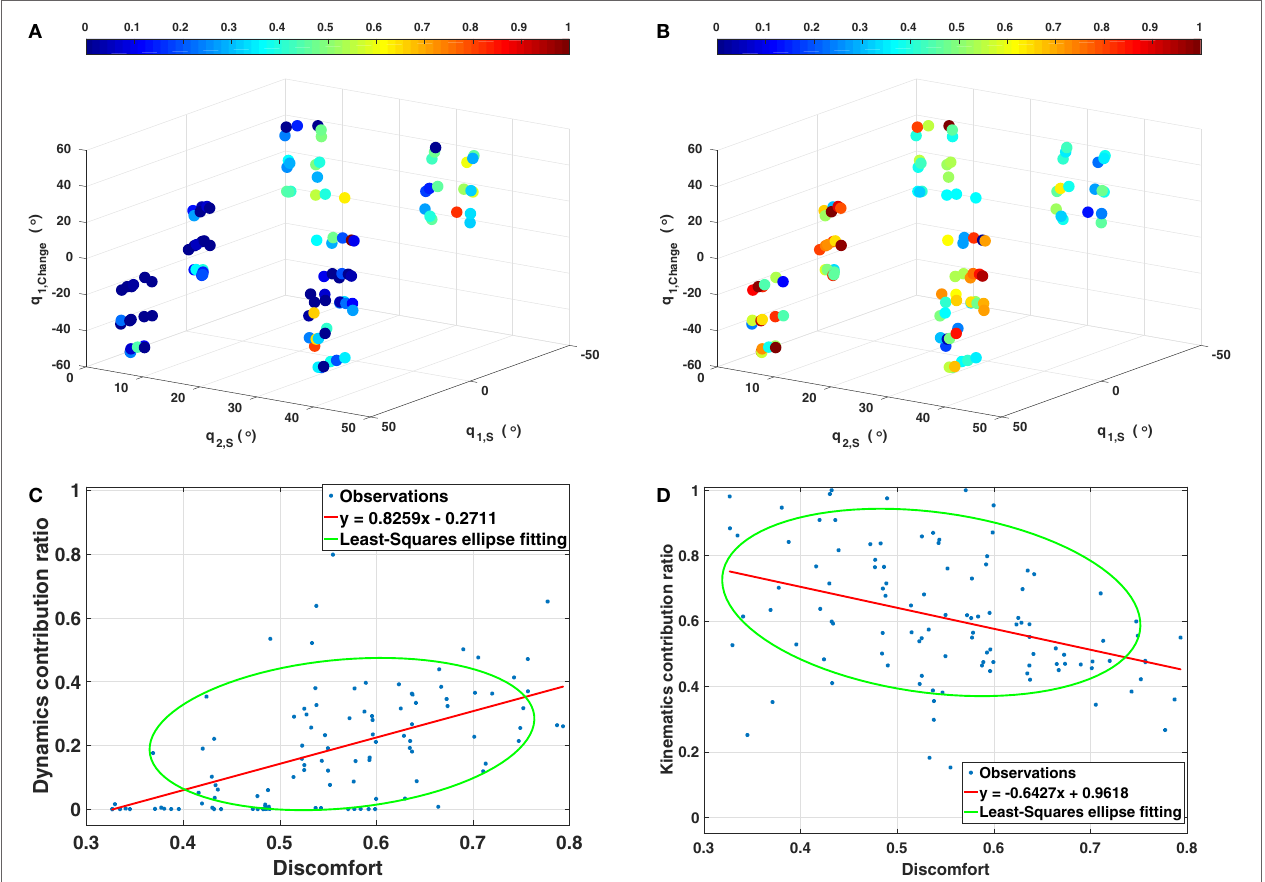
FIGURE 8 | Transition between different cases. (A,B) Contribution of the dynamics (left) and the kinematics (right) related costs with respect to three factors. q 1 ,S , q 2 ,S are the two starting joint angles of the shoulder rotations, q 1 ,Change is the change between the final and the initial angle of the pitch rotation of the shoulder joint. The colors indicate the contribution ratio of corresponding cost. (C,D) Relationship between the proposed discomfort metric and the contribution of the dynamics and the kinematics related costs. Red lines are the linear regression models created based on the discomfort value with respect to the optimal weights ( (cid:12) ∗ 1 ;(cid:12) ∗ 2 ) . Another least-squares ellipse fitting is also presented to demonstrate the trend with